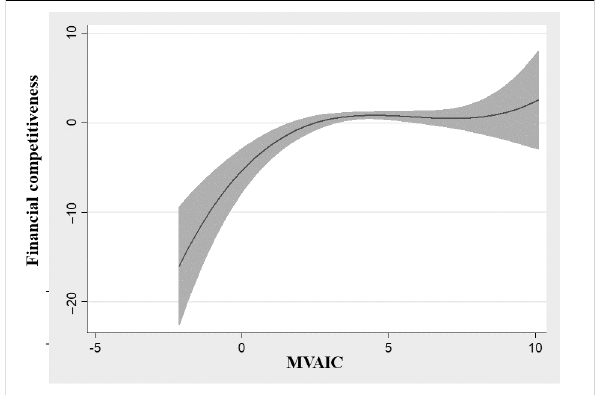
FCFigure 1. The cubic relationship between IC and